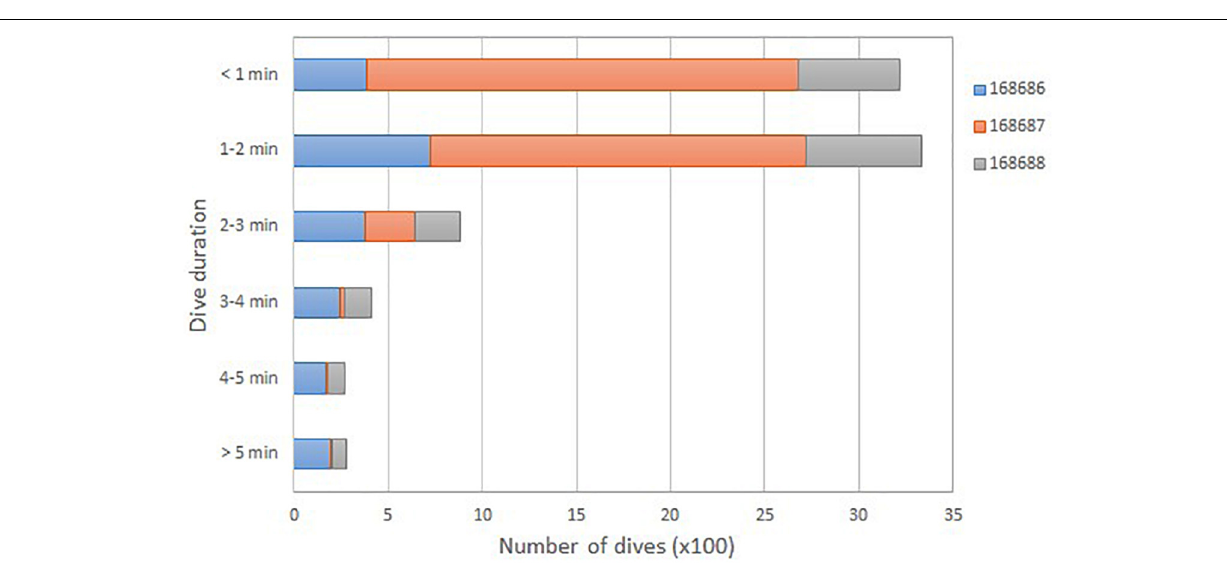
movements northwards along the coast and the shelf break before engaging in ARS in other